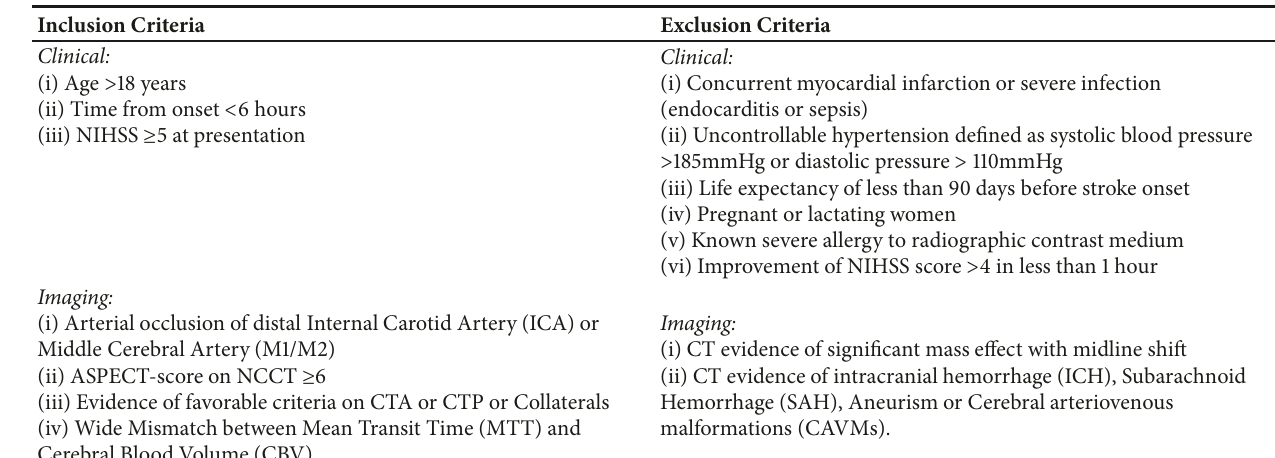
Table 1: Clinical and imaging inclusion and exclusion criteria of